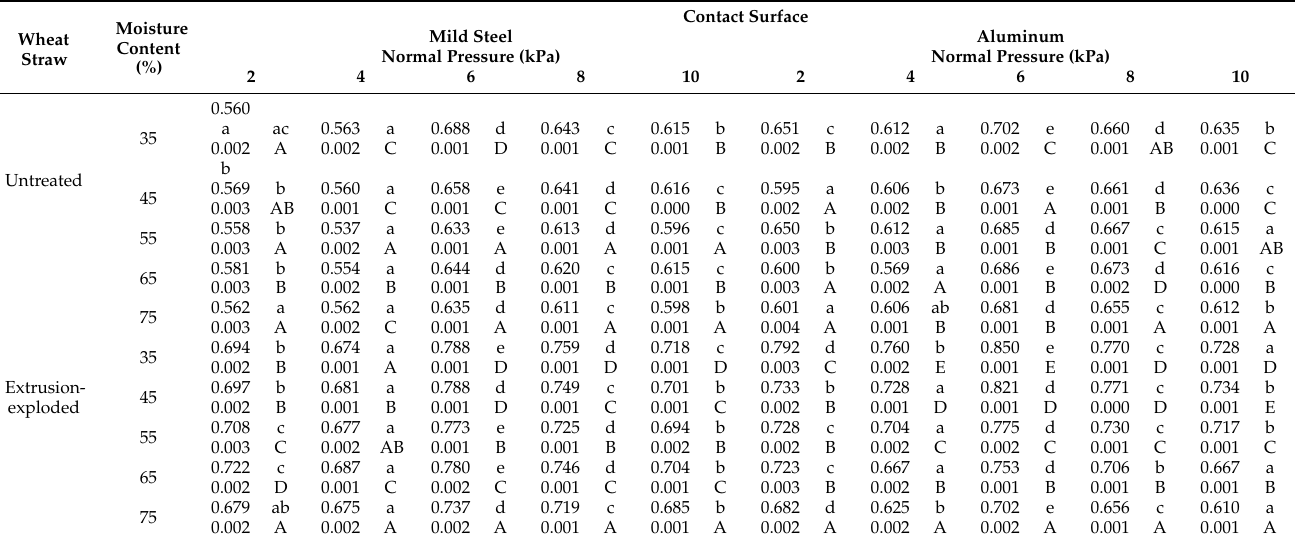
Table 2. Coefficient of sliding friction of wheat straw on mild steel and an aluminum surface with different levels of moisture content and normal pressure